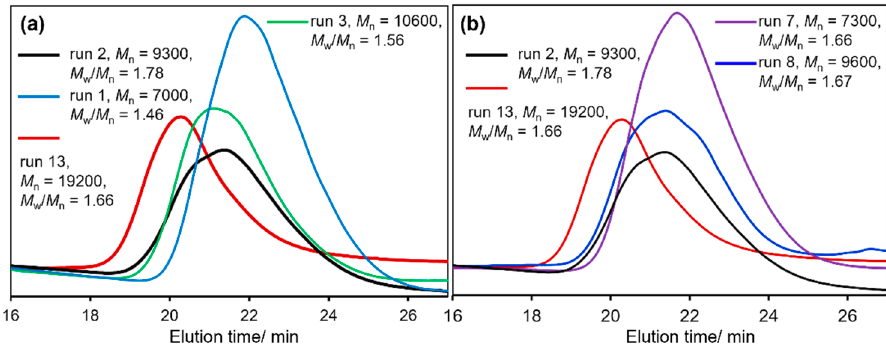
Figure 1. GPC traces in the resultant poly(M1- co -DCD)s. ( a ) Time course (runs 1–3), ( b ) effect